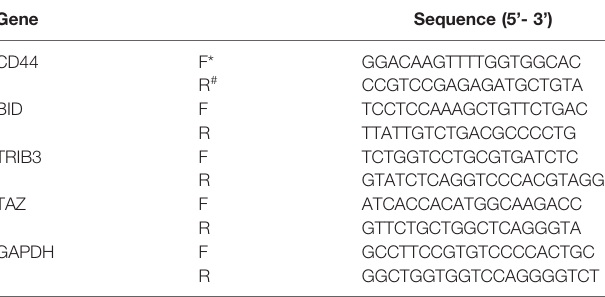
TABLE 1 | Primer sequences of related genes for